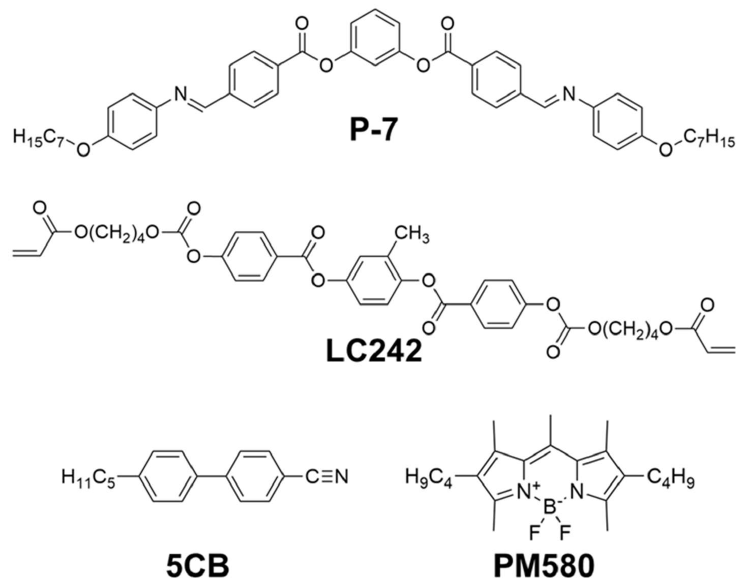
Figure 2. Chemical structures of P-7, LC242, 5CB, and PM580 used in this study.